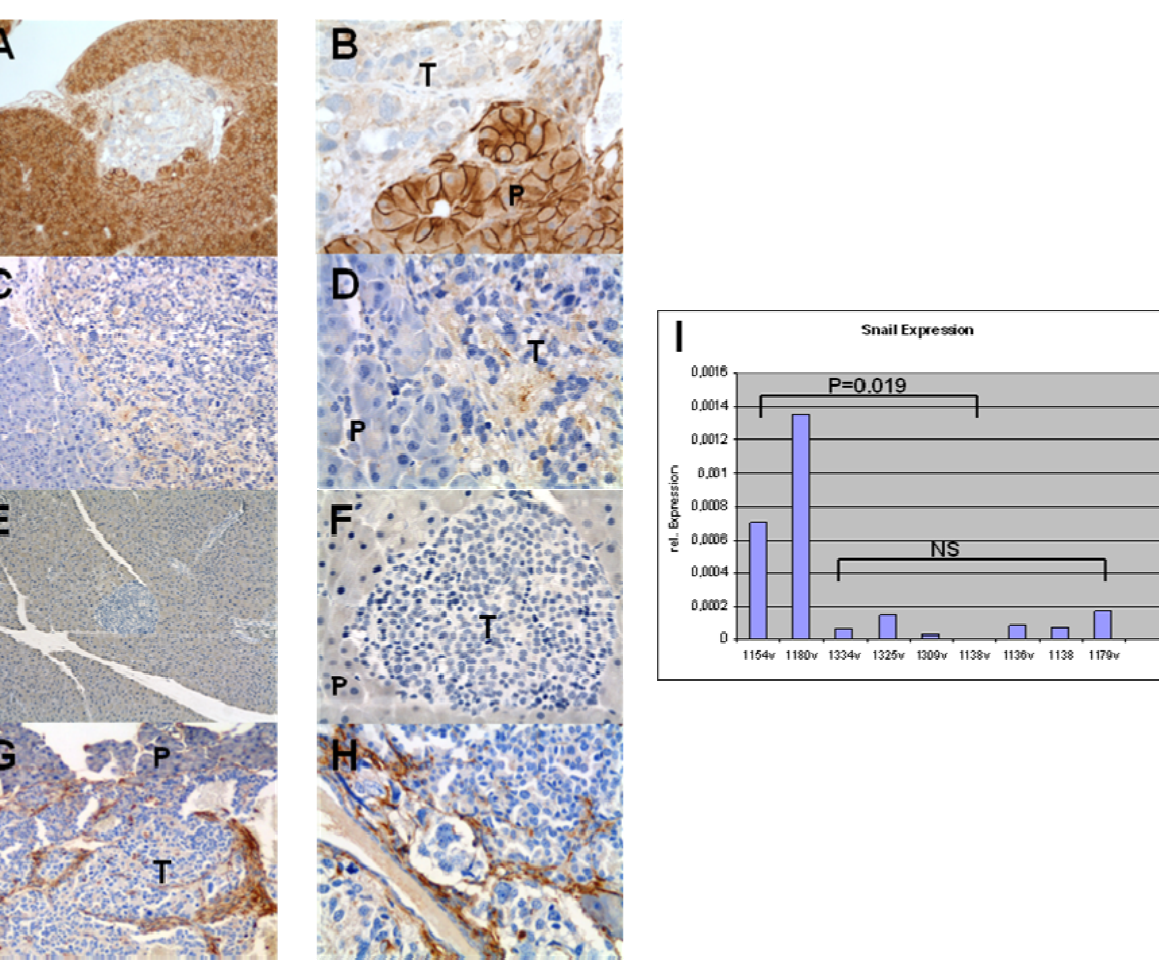
Figure 4. (A, B) IHC staining for E-Cadherin in tissue samples from Rip1Tag2 islet cell tumors shows loss of E-cadherin in most islet cell tumors. (C, D) IHC staining for Snail in tissue samples from Rip1Tag2 islet cell tumors, revealing slight expression of Snail in tumor tissue. (E, H) IHC staining for Twist in tissue samples from Rip1Tag2 islet cell tumors. Virtually all islet cell tumors were absent for Twist expression.(G, H) IHC staining for Vimentin in tissue samples from Rip1Tag2 islet cell tumors. Stromal cells within the tumor showed strong positive staining for the mesenchymal marker vimentin (P = normal pancreas, T = islet cell tumor). (A, C, E, G 10x; B, D, F, H 40x magnification). (T) Tumor, (P) normal pancreas. (I) Snail was down regulated in islet cell tumors by PEG. Quantitative real-time PCR on RNA demonstrates profound down-regulation of Snail in treated mice (1334v, 1325v, 1309v, 1138v, 1136v, 1138) vs. control mice (1154v, 1180v,